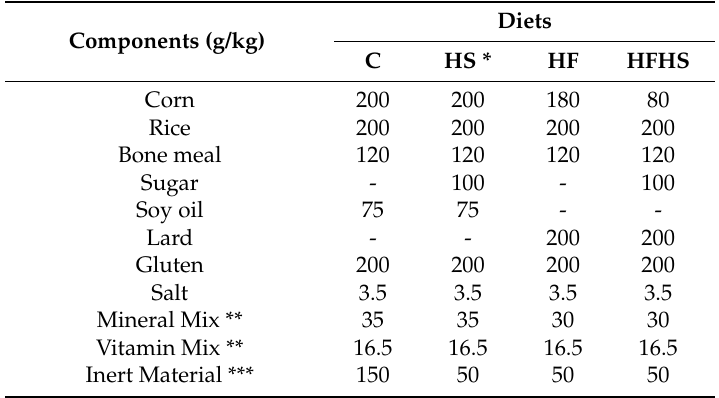
Table 1. Composition and nutritional values of diets used in the experiment.